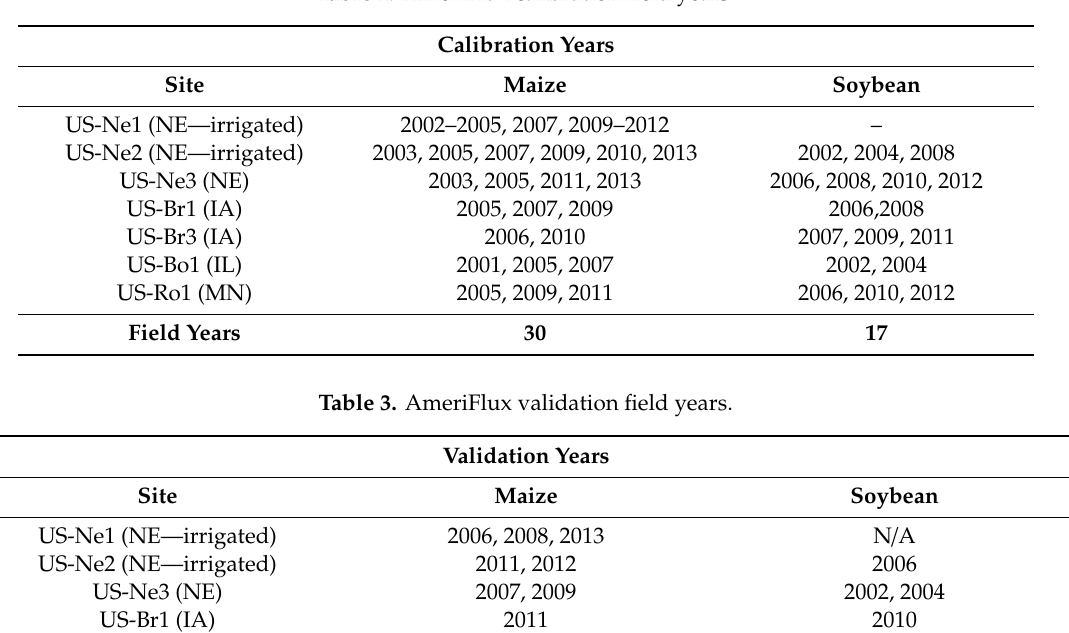
Table 2. AmeriFlux calibration field years.